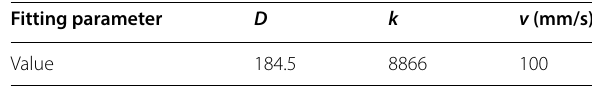
Table 2 Equation parameter of Eq. (9) Fitting parameter